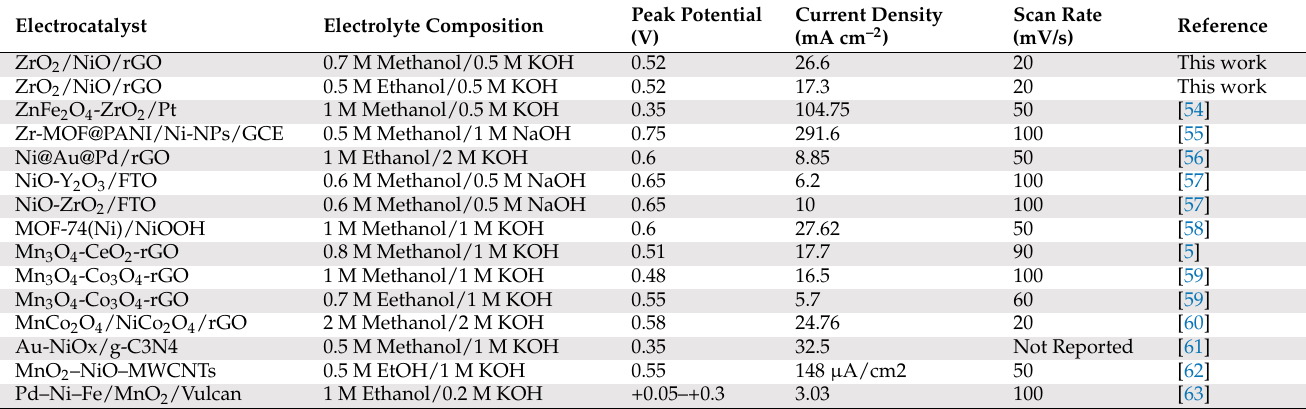
Table 1. Comparison of MOR and EOR performances of ZrO 2 /NiO/rGO nanocatalyst with other research.